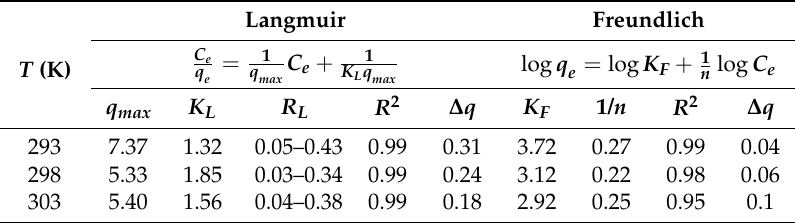
Table 2. Calculated isotherm parameters via linear regression.